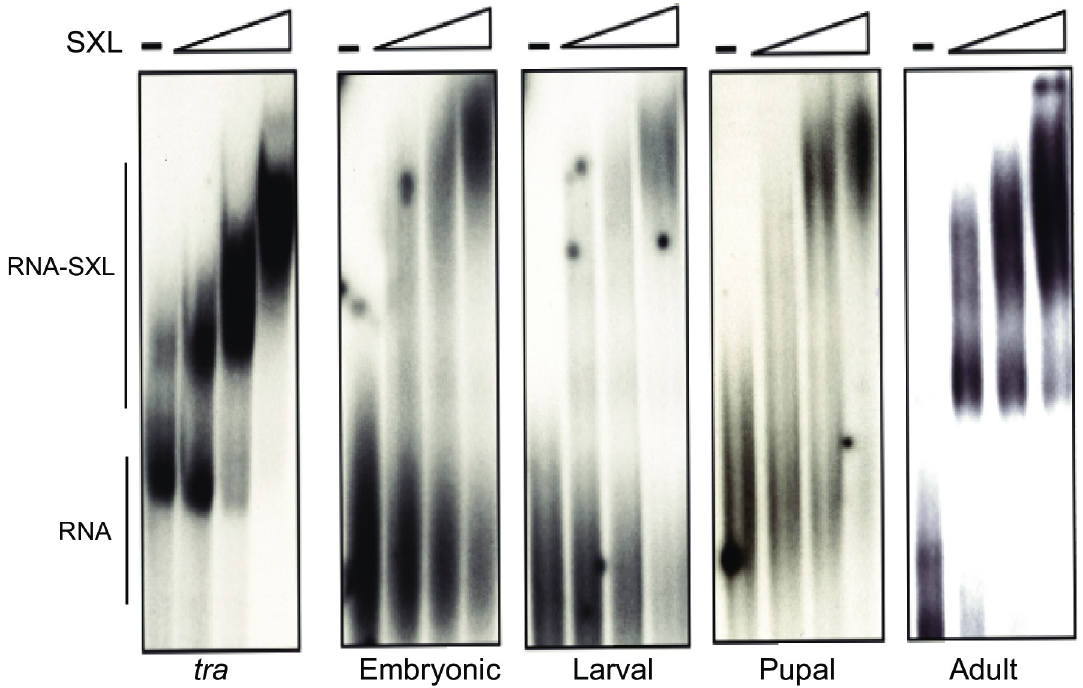
Fig 4. Binding of SXL to RNA pools from different cDNA SELEX libraries. Electrophoretic gel mobility assay was used to determine binding affinity of SXL with the non-sex-specific polypyrimidine-tract/3’splice site of tra , and the pool 6 RNA of the SXL-selected sequences for cDNA libraries (prepared from embryonic, larval, pupal, and adult polyA + RNAs). No SXL is shown by the–lane, and increasing concentrations (three-fold successive increase) of the recombinant GST-SXL protein are shown by the triangles. The–lane shows the free (unbound) RNA, and RNA-protein complexes are shown under various SXL concentrations (166 ng/ μ l; 55 ng/ μ l; 18 ng/ μ